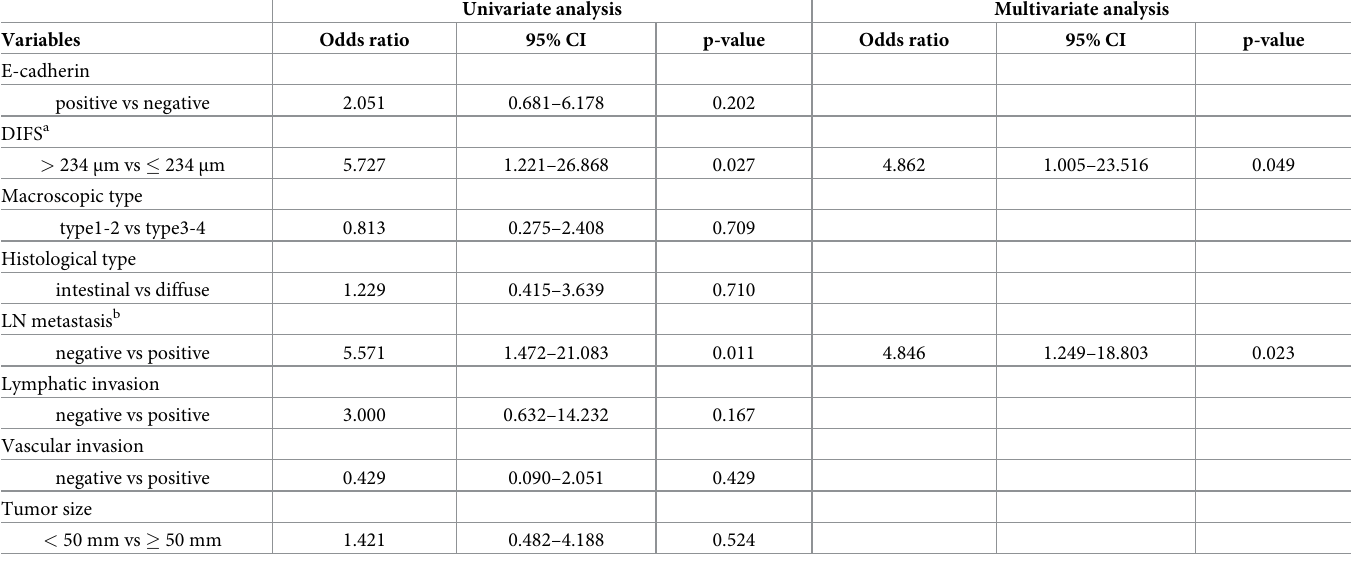
Table 2. Univariate and multivariate analysis with respect to peritoneal